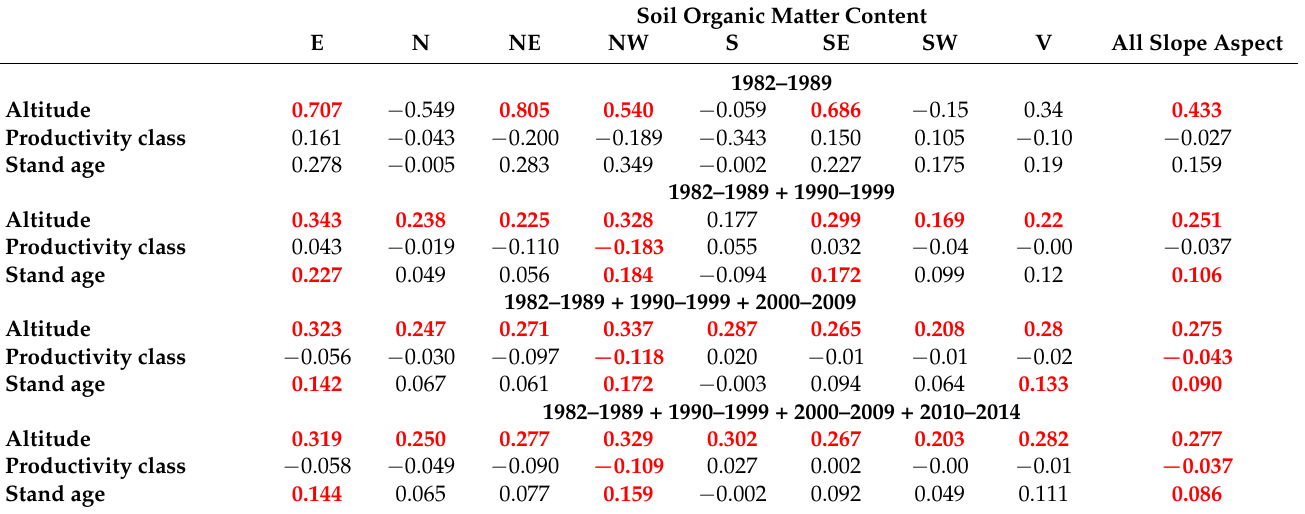
Table 4. Spearman correlation coefficient values for eutric cambisol in the Ao